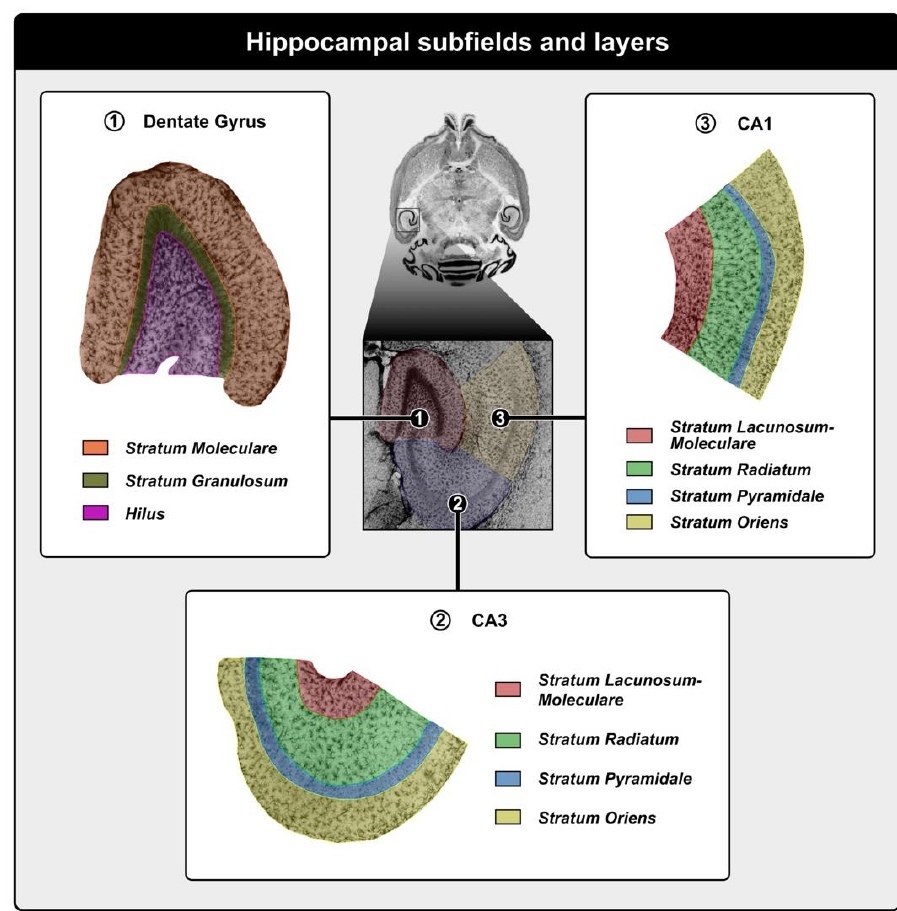
Figure 6. Photomicrograph of the regions of interest and analyzed layers (low-power magnitude, 4×, inset in the center). In the center, we observe a horizontal section of the Mus musculus mouse brain, highlighting regions of hippocampal formation immunolabeled for GFAP. They are: ( 1 ) Dentate gyrus: showing the stratatum moleculare and hilus, respectively, by the colors orange and pink. ( 2 ) CA3, containing 4 regions: Stratum lacunosum-moleculare (in red), Stratum radiatum (green), Stratum pyramidale (blue), and Stratum oriens (yellow). ( 3 ) CA1, containing 4 regions, homonymous to the CA3 region. The horizontal section in the center of this figure was extracted from a virtual mouse brain atlas and can be accessed via the following link: https://www.mbl.org/atlas232/atlas232_frame.html.